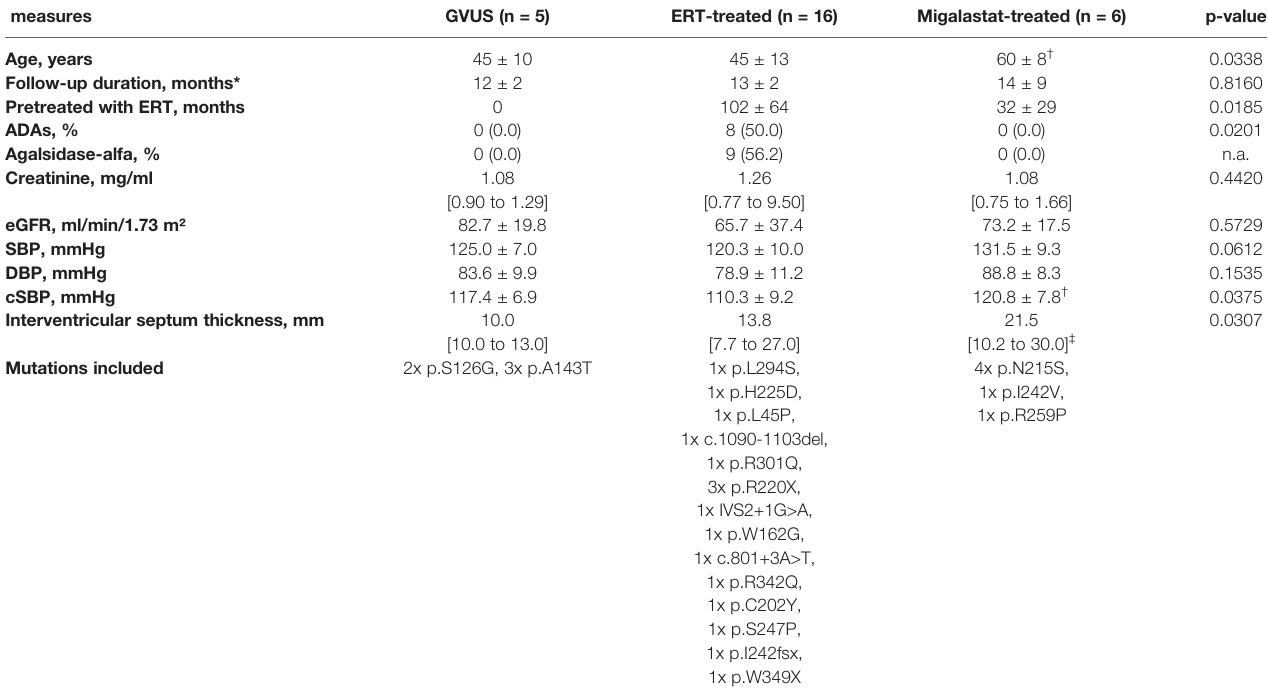
TABLE 1 | Characteristics of the study cohort at fi rst GlycoCheck and PWV measurement (T1).